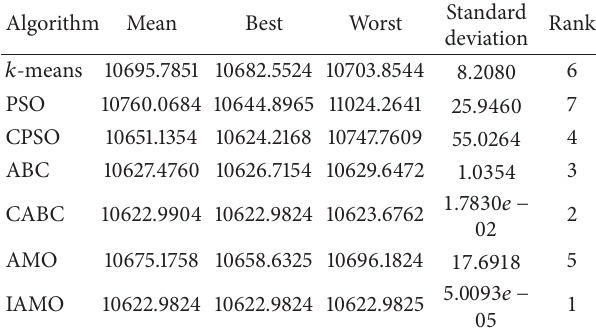
Table 7: Results obtained by the algorithms for 20 different runs on StatLog (heart) data.